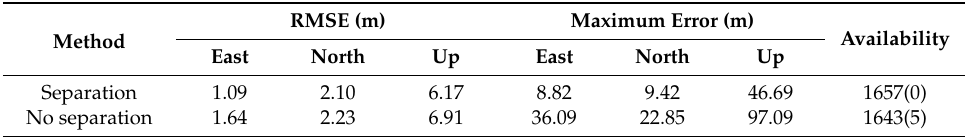
Table 11. The e ff ect of Chi-square separation on the positioning results of D1 using HDBSCAN anomaly detection and